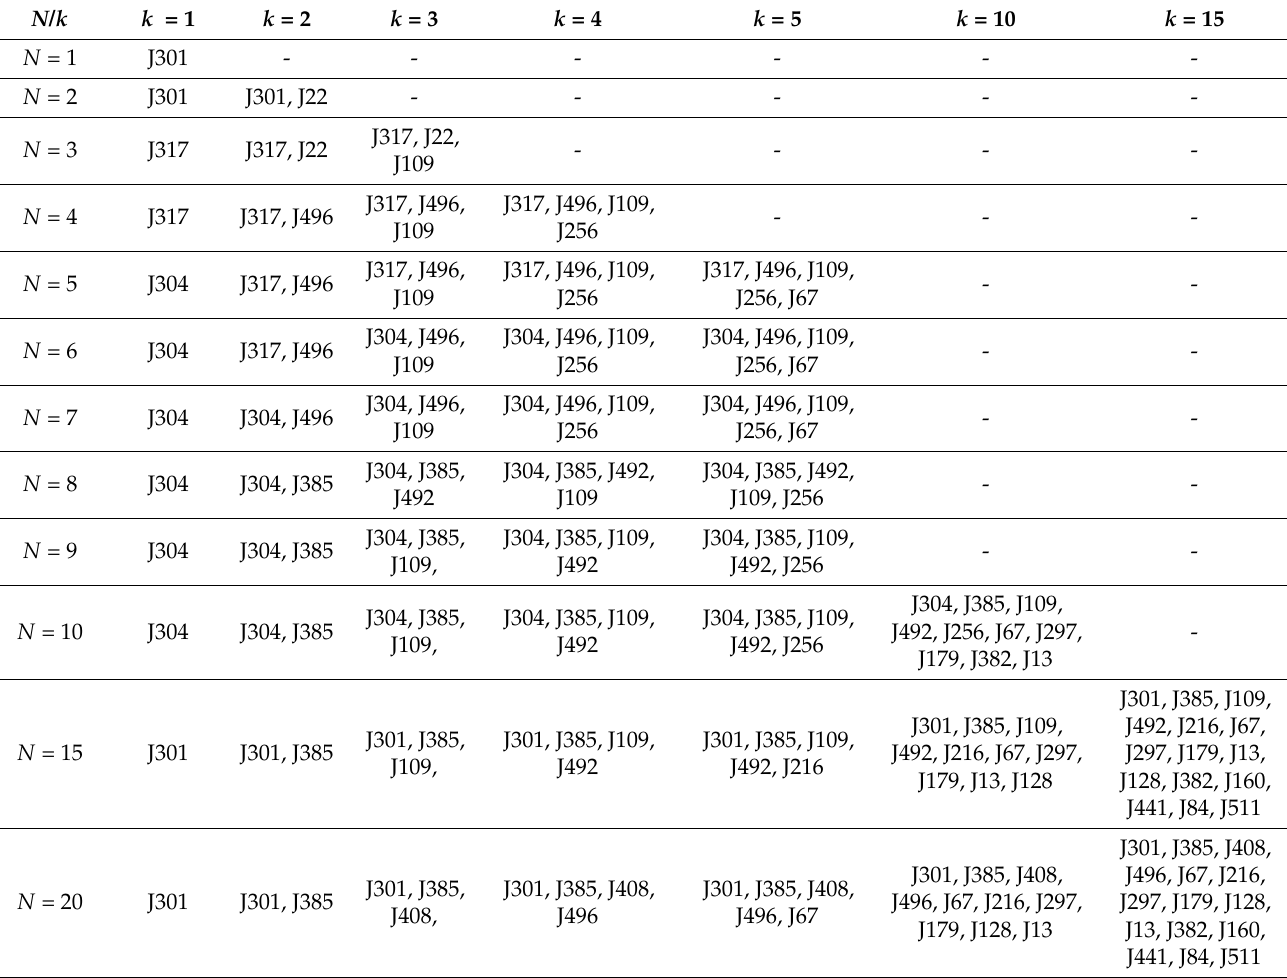
Table 2. Sensors under cyber-attack for each scenario set and sensor